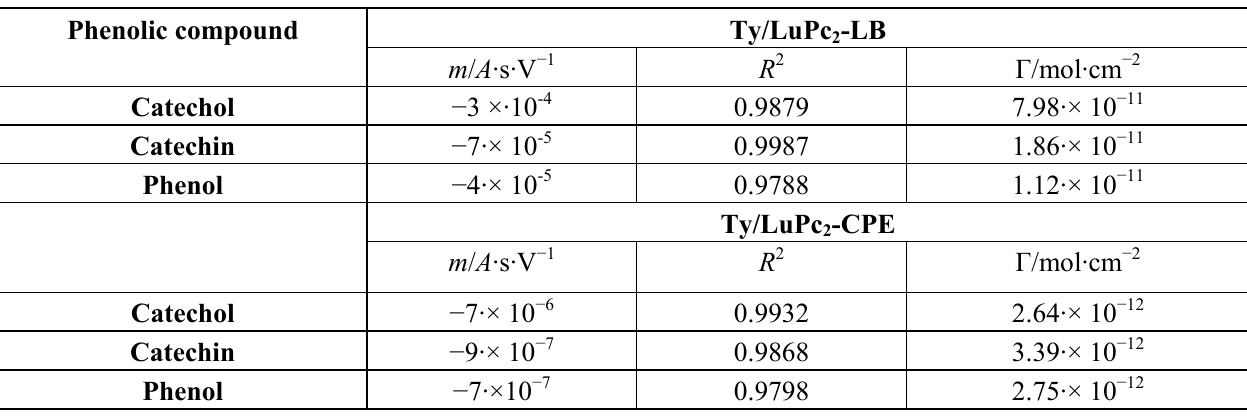
Table 1. Quantitative data obtained from influence of scan rate in biosensors response studies applied to the cathodic peak at 0.1